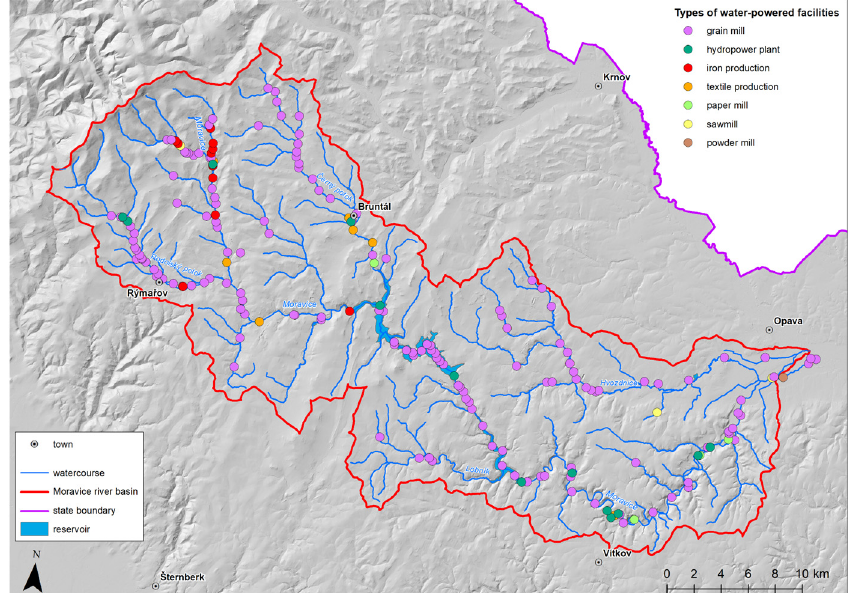
Figure 3. The types of water-powered facilities in the Moravice river basin, as defined in the topographic maps (the type reflects the first occurrence of the facility).